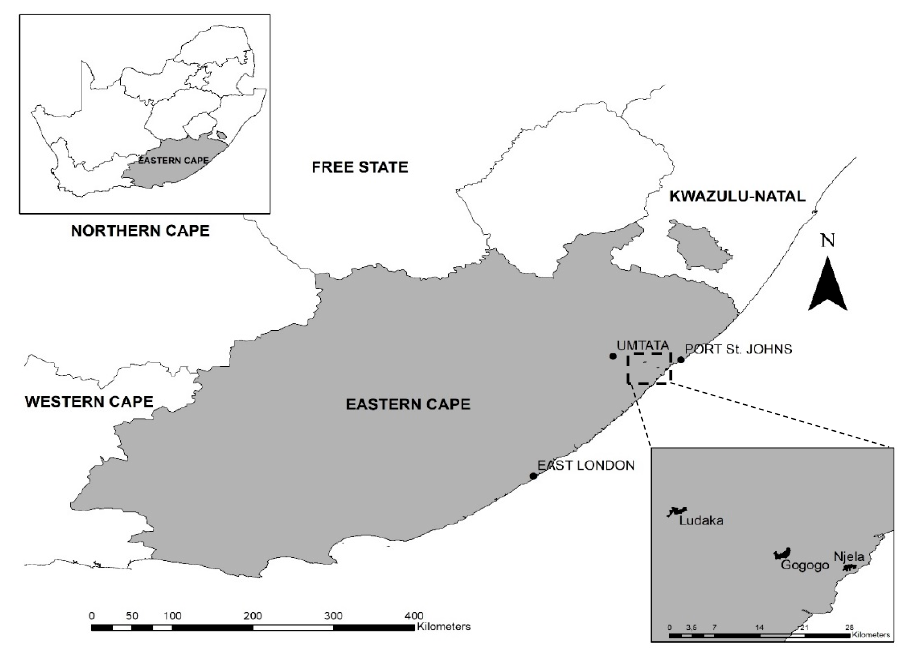
Figure 1. Location of Njela, Gogogo and Ludaka.